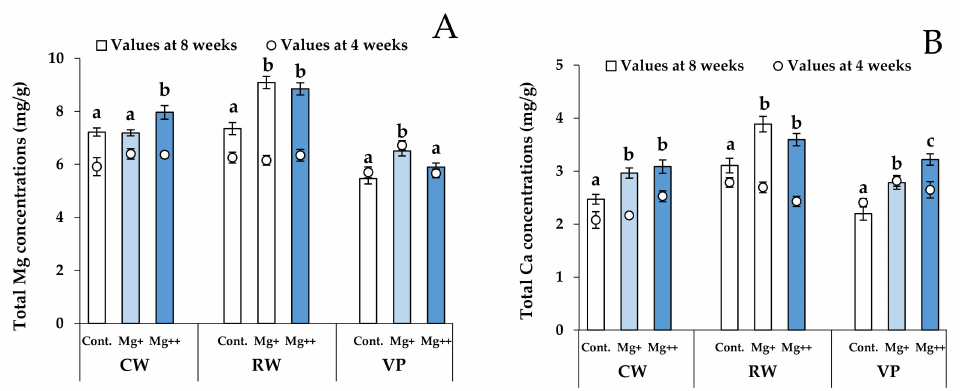
Figure 2. Total Mg ( A ) and Ca concentrations ( B ) in each cultivar and each treatment at 4 (scatter plots) and 8 weeks (bar graph). Data are means ± SE. Significant differences among means are indicated by different letters. Cultivars: Celeb Wine (CW), Reina White (RW), and Voyage Peach (VP). The total Ca concentrations in all cultivars are shown in Figure 2B. For CW and VP, the total Ca concentrations increased with increasing nutritional Mg concentrations (Figure